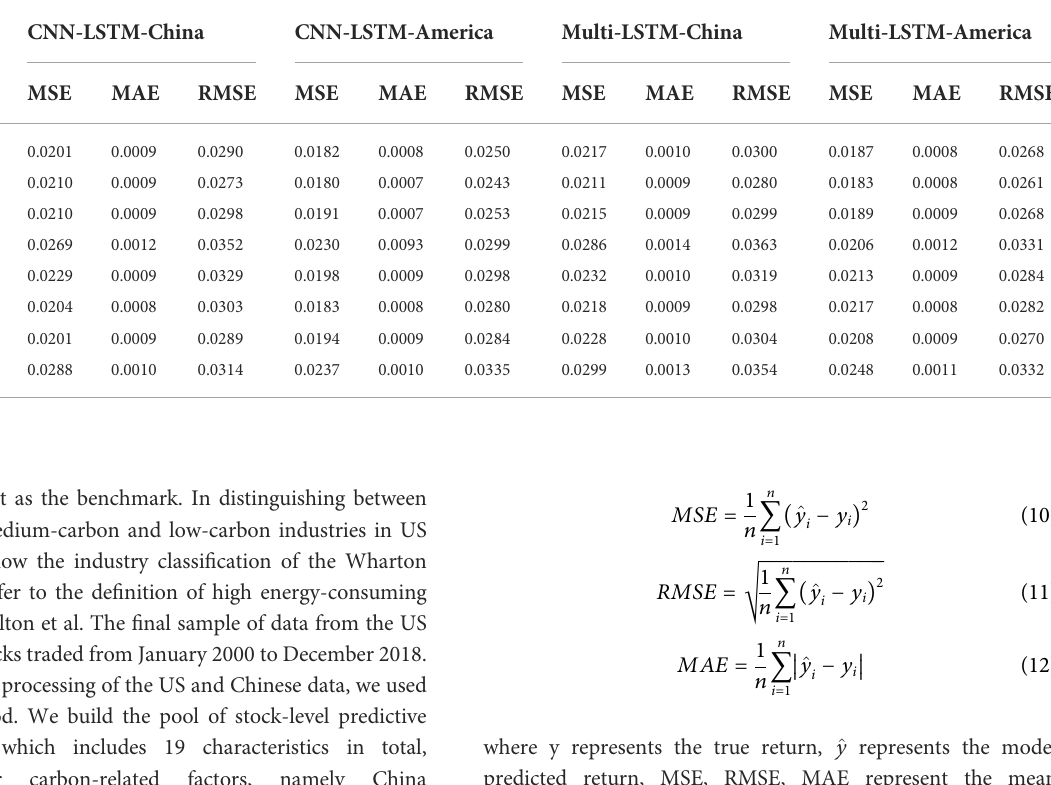
TABLE 1 Evaluation of prediction accuracy using Multi-LSTM method and CNN-LSTM method with and without carbon factor in feature engineering Note: This table records the values of MSE, RMSE and MAE used to evaluate the prediction accuracy of Multi-LSTM method and CNN-LSTM method. And all, high, mid as well as low represent the full stock, high-carbon, medium-carbon as well as low-carbon sectors respectively. Meanwhile,thevaluesofChinesemarketandAmericanmarketarerecordedrespectively.Overall,inthecaseoffeatureengineeringwithandwithout carbon factor, the values of each forecast accuracy assessment indicator in different industries are small, indicating that the methodology has good forecasting effect and high forecast